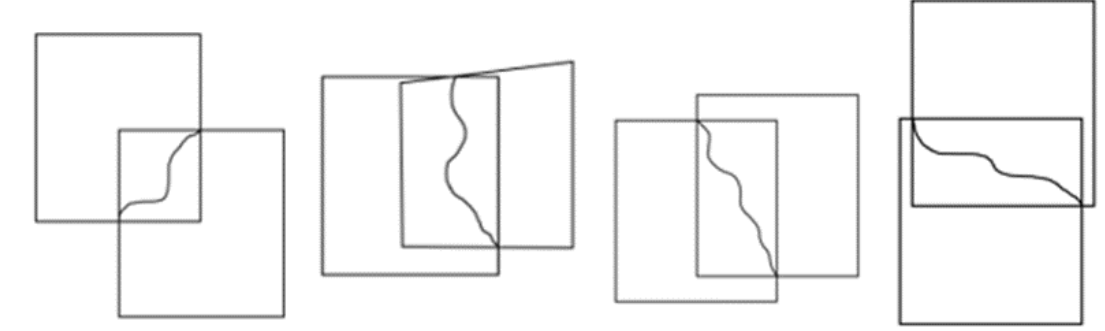
Figure 4. Different location relations of remote sensing images of very large files.